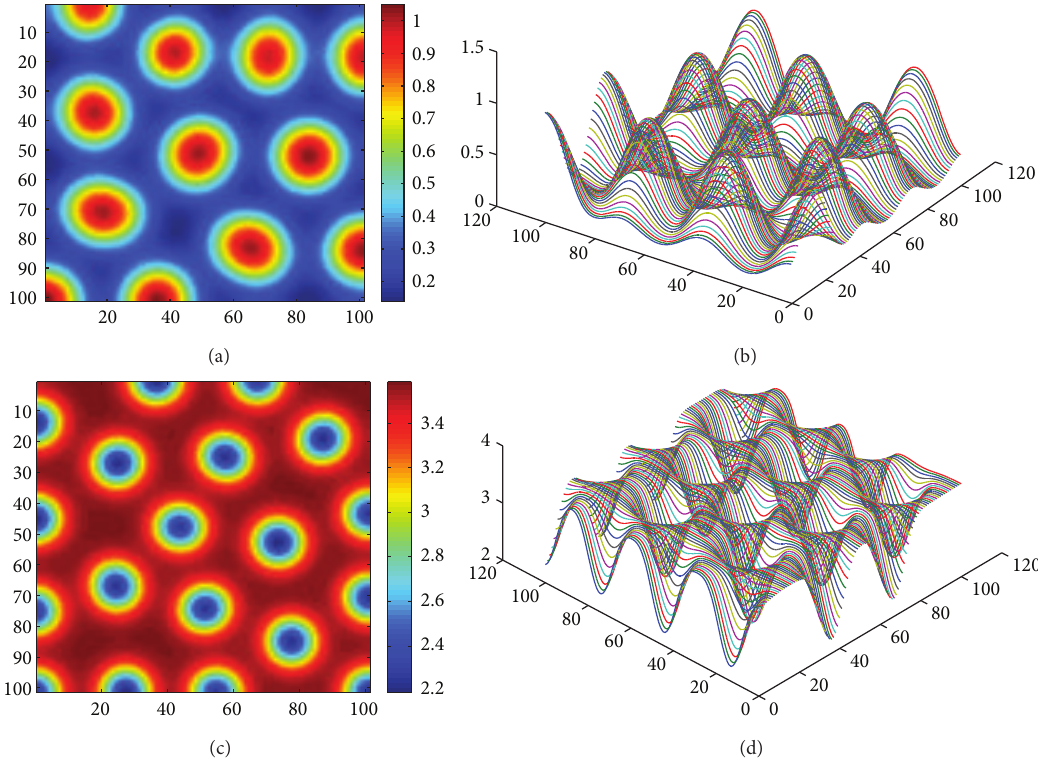
Figure 4: Pattern dynamics of model (12) in two- and three-dimensional space. (a) spots pattern; (b) spots pattern in three-dimensional space; (c) holes pattern; (d) holes pattern in three-dimensional